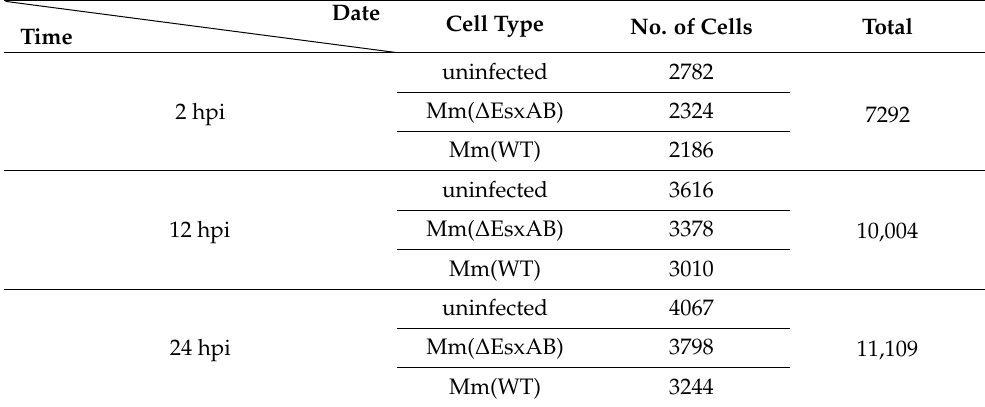
Table 1. THP-1 cell dataset for Cell-net classification.